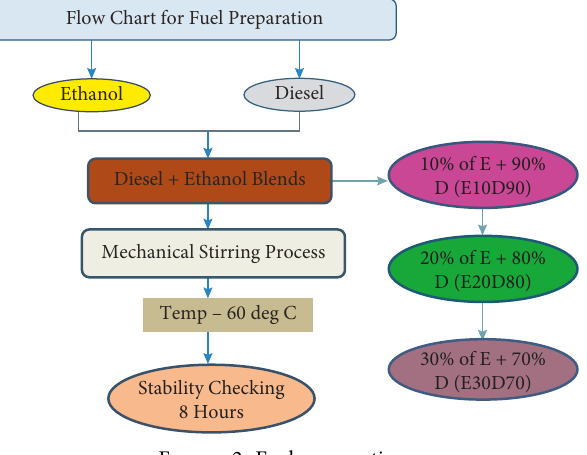
Figure 2: Fuel preparation. Table 5: AVL exhaust gas analyzer.